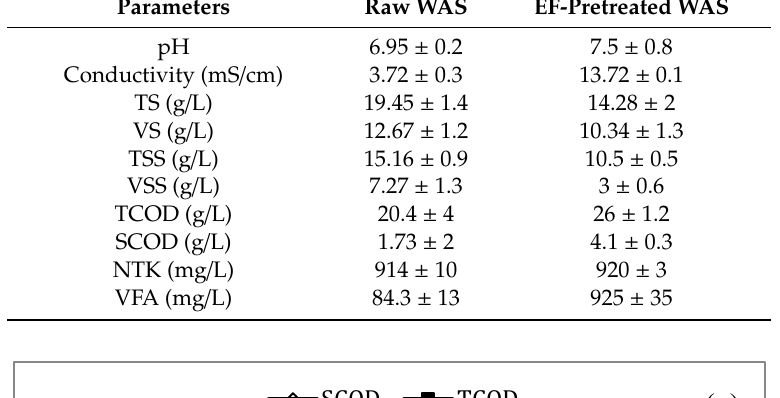
Table 1. Physicochemical characteristics of waste activated sludge (WAS) before and after pretreatment. Parameters Raw WAS